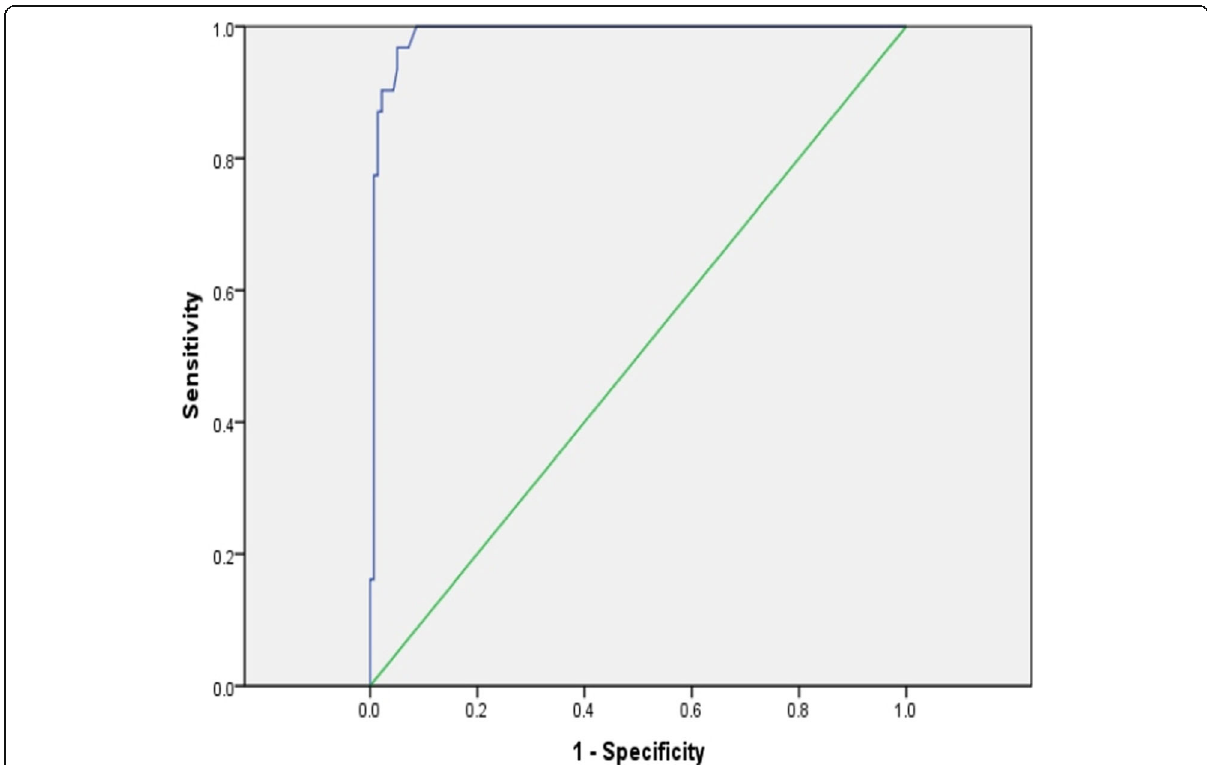
Fig. 1 Receiver operating characteristic (ROC) curve plotted to obtain the optimal cut-off value of ApoB/ApoA-I ratio in order to predict the presence of significant ≥ 2 vessel disease in NSTE-ACS